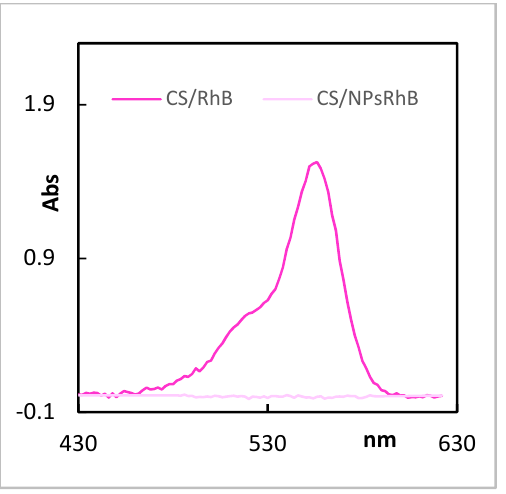
Figure 3. The UV − Vis spectrum of the solution of 0.9% NaCl released Rhodamine B from the investigated